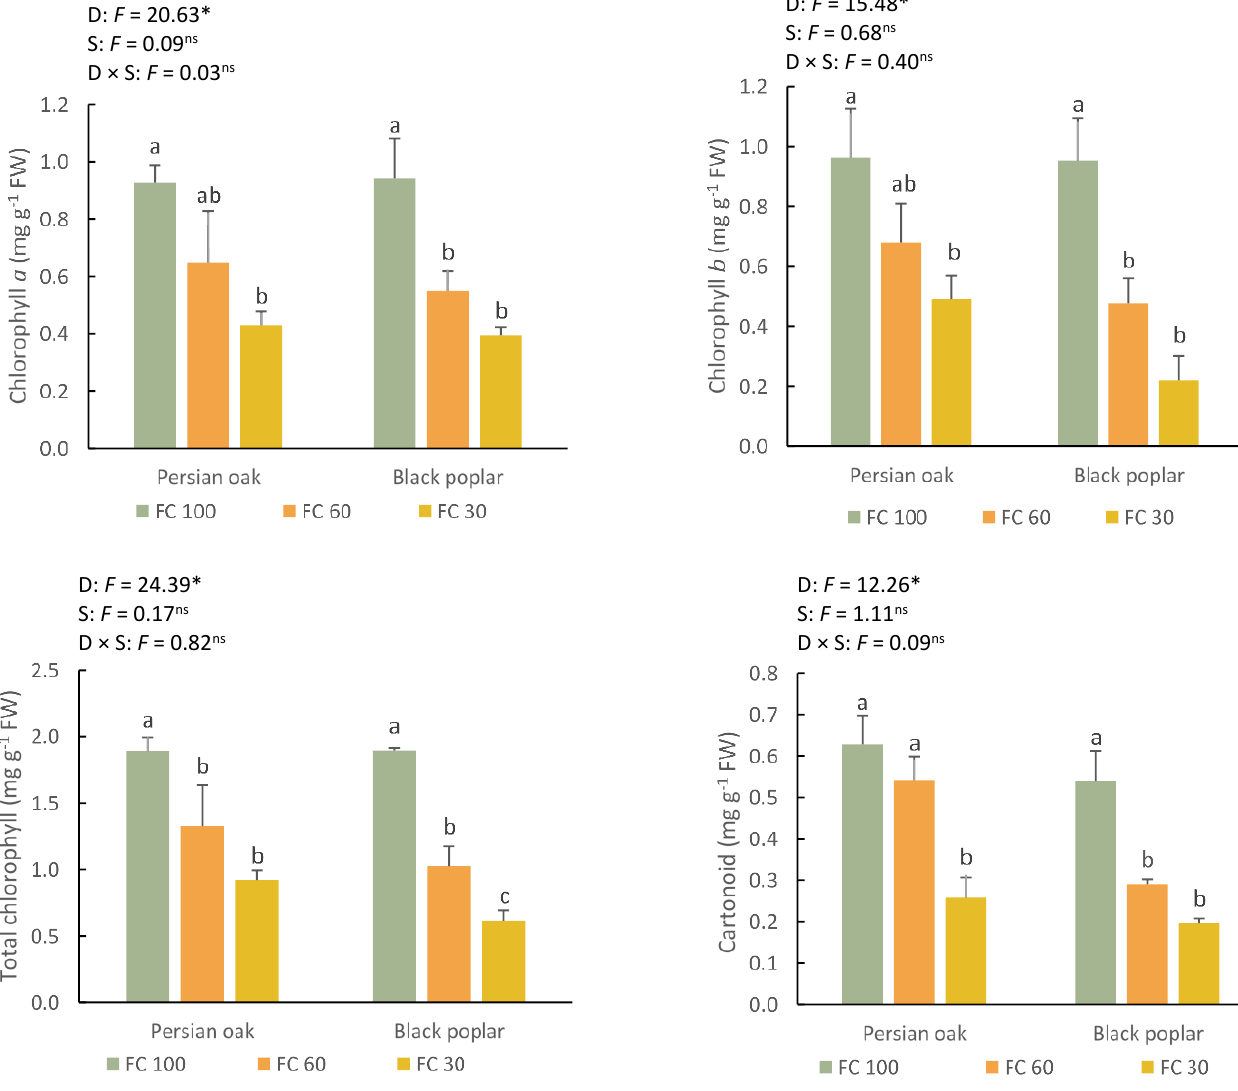
Figure 4. Foliar chlorophyll ( a , b , and total) and carotenoid content of Persian oak and black poplar seedlings as a function of soil water deficit. Means ± standard deviation, n = 3 blocks. Different lower-case letters indicate statistically significant differences based on Duncan’s multiple range post-hoc test ( α = 0.05). In the presence of a significant interaction between drought (D) and species (S), the significance letters are valid across species but only remain valid within species when the interaction (D × S) was not significant. FW = fresh weight. * p < 0.05.